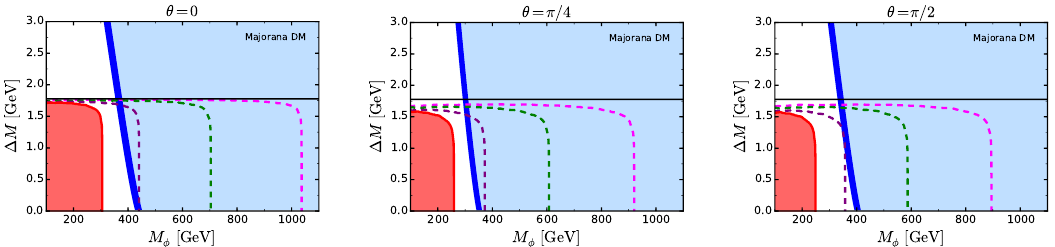
Figure 8 . Model 1b: (cid:30) (cid:31) co-annihilation strip and collider searches. The dark-blue region (cid:0) satis(cid:12)es the correct dark matter relic abundance within 3 (cid:27) , the light-blue region overproduces the dark matter energy density. The horizontal black line corresponds to the mass of the (cid:28) lepton. The region coloured in red corresponds to current HSCP limits for center-of-mass energy of 8 TeV and 18.8 fb (cid:0) 1 . The three dashed lines (purple, green and magenta) correspond to our projections for center-of-mass energy of 13 TeV and 30, 300 and 3000 fb (cid:0) 1 of integrated luminosity